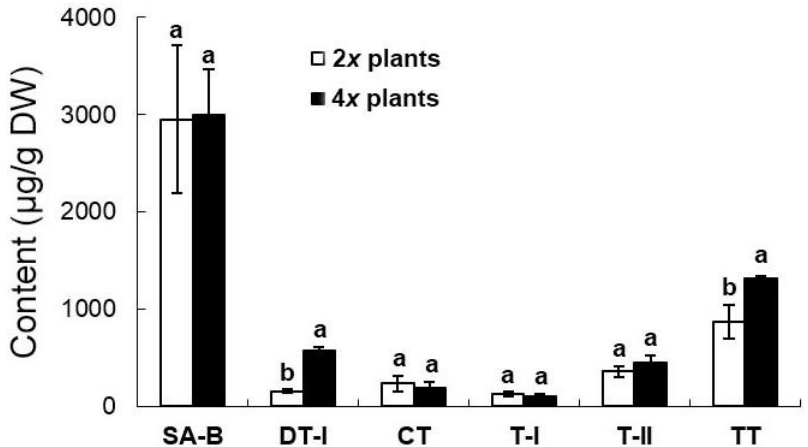
Figure 8. Medicinal constituents in roots of 2 x and 4 x plants of Salvia miltiorrhiza . According to DMRT ( P ≤ 0.05), the means ± standard errors that followed by the same letter were regarded as not significantly different. CT: cryptotanshinone; DT-I: dihydrotanshinone I; T-I: tanshinone I; T-IIA: tanshinone IIA; SA-B: salvianolic acid B; TT: total tanshinones = the sum of CT, DT-I, T-I and T-IIA.